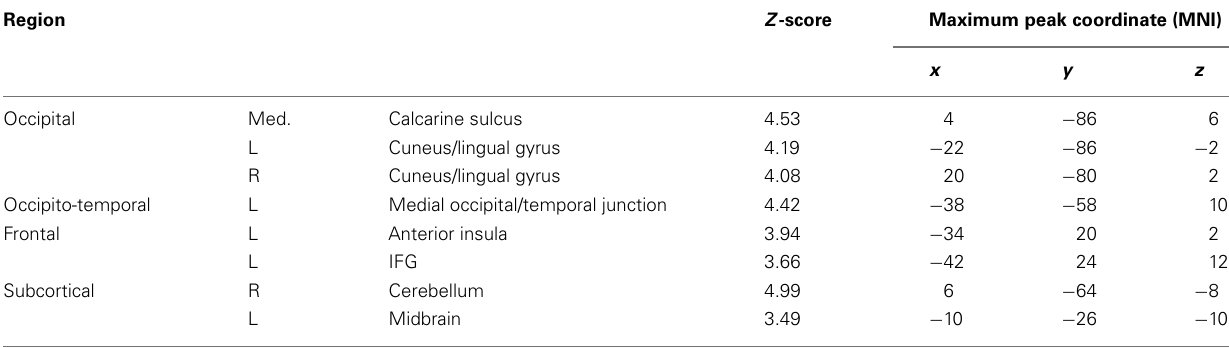
Table 1 |Activated regions in the visual orthographic decision compared to visual control task.